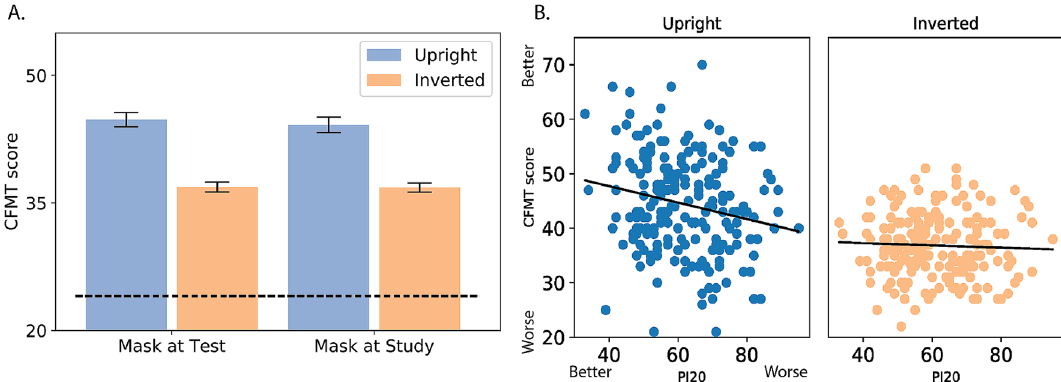
Figure 3. Results of Experiment 2: ( A ) Results of the CFMT experiment when faces were masked only during the test phase or the study phase. The results are similar to those obtained from the group in which faces were masked during both study and test phases. ( B ) Correlation between self-reported face perception abilities (extended PI20) and the CFMT results for upright and inverted